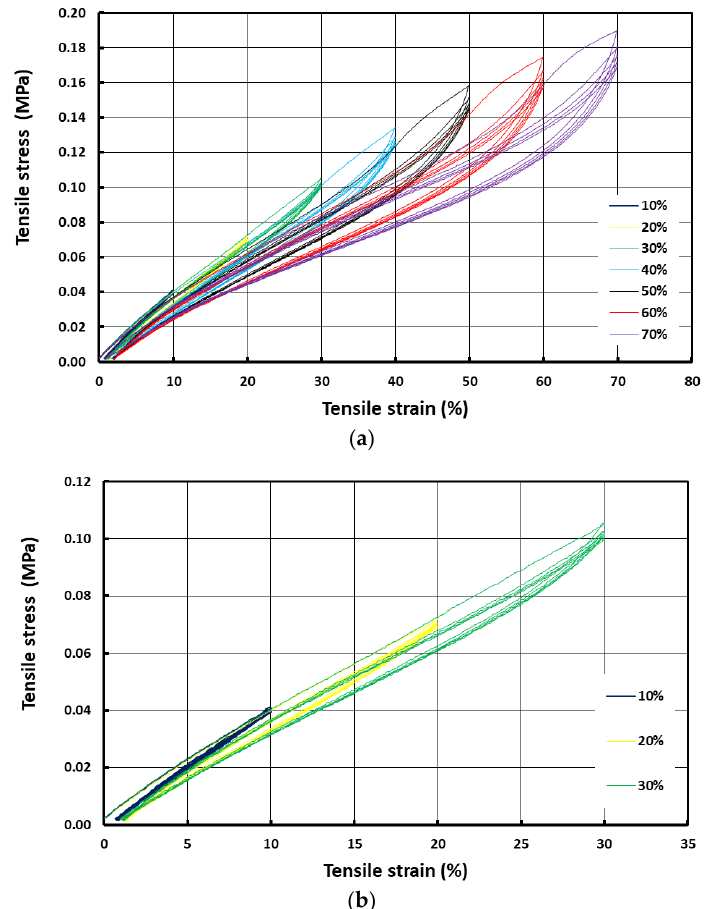
Figure 3. Typical stress vs. strain curves of strip sample in cyclic uniaxial tension at room temperature ( a ) from 10% to 70% strain with an increment of 10% at each step; ( b ) zoomed in portions of the initial part of the curves at 10%, 20% and 30% strains.